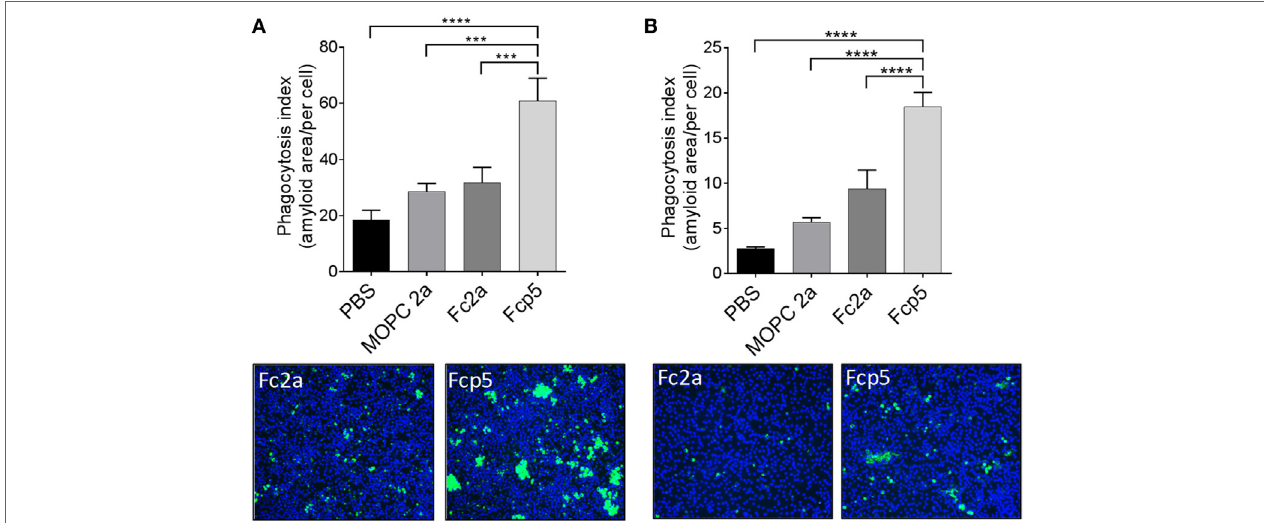
FigUre 5 | Phagocytosis of AL amyloid-like fibrils and human ATTR extracts is enhanced by opsonization by Fcp5. Quantitative estimation of phagocytosis of pHrodo green-labeled rV λ 6Wil amyloid-like fibrils (a) and human ATTR amyloid extract (B) . Addition of Fcp5 significantly enhanced phagocytosis of the substrate by adherent RAW264.7 cells. Images of the engulfed (fluorescent) substrate demonstrate the qualitative difference between Fc2a and Fcp5 incubation. Original